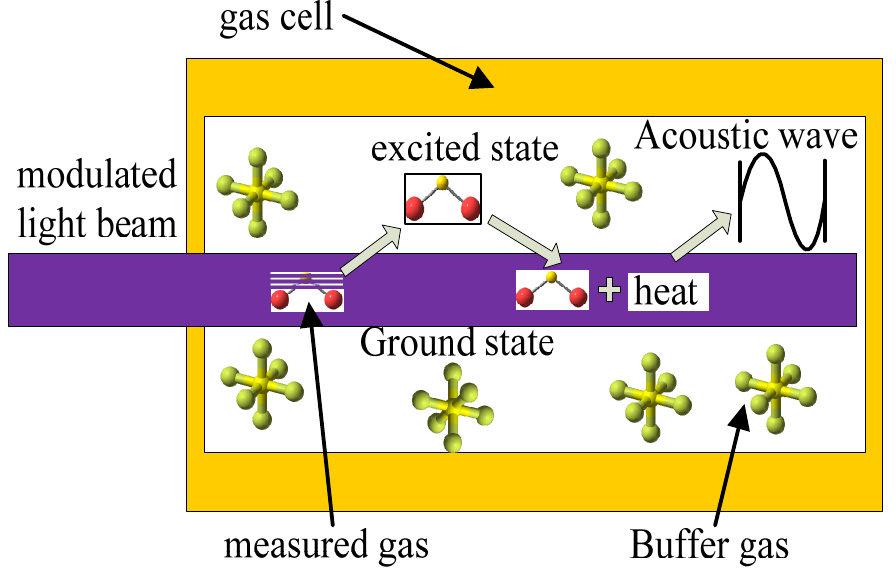
Figure 1. Schematic diagram of PAS. The modulated light beam enters the gas cell and transmits along the axis of the gas cell. The gas molecules absorb the light at certain wavelengths and are excited from